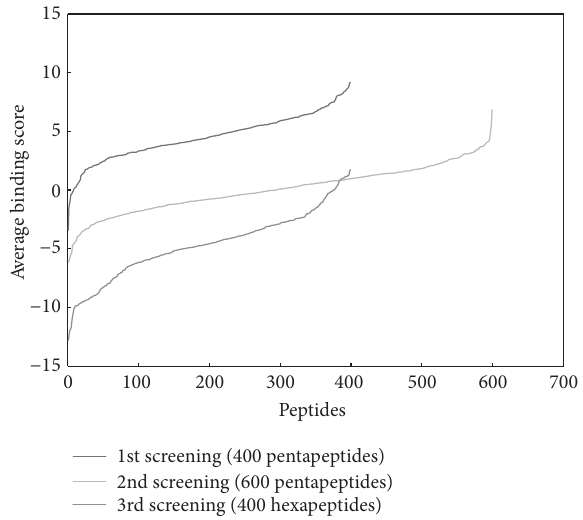
2nd screening (600 pentapeptides) 3rd screening (400 hexapeptides) Figure 2: Results obtained in the 3 virtual screening steps. Average binding score trend decreased from first to third step, indicating a better receptor-ligand affinity. Average binding scores were calcu- lated using 10 peptide conformers versus all 189 PCDDs and PCDFs.